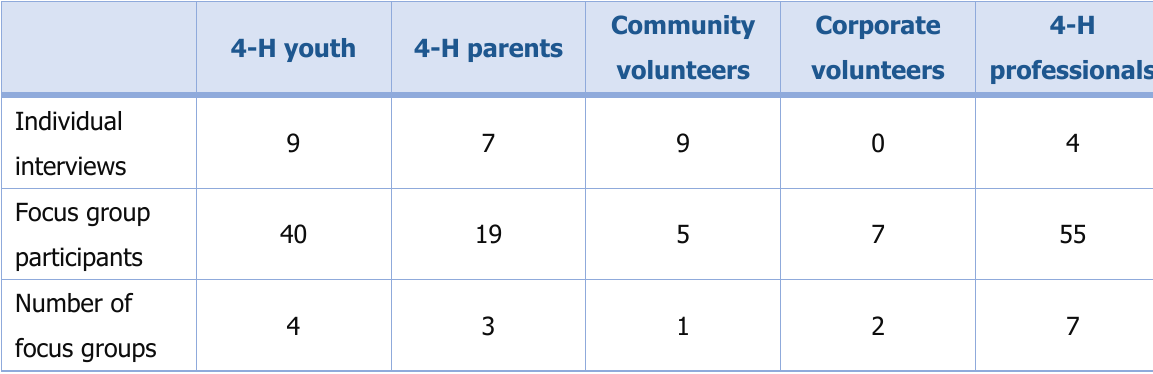
Table 1. Participants in Focus Groups and Individual